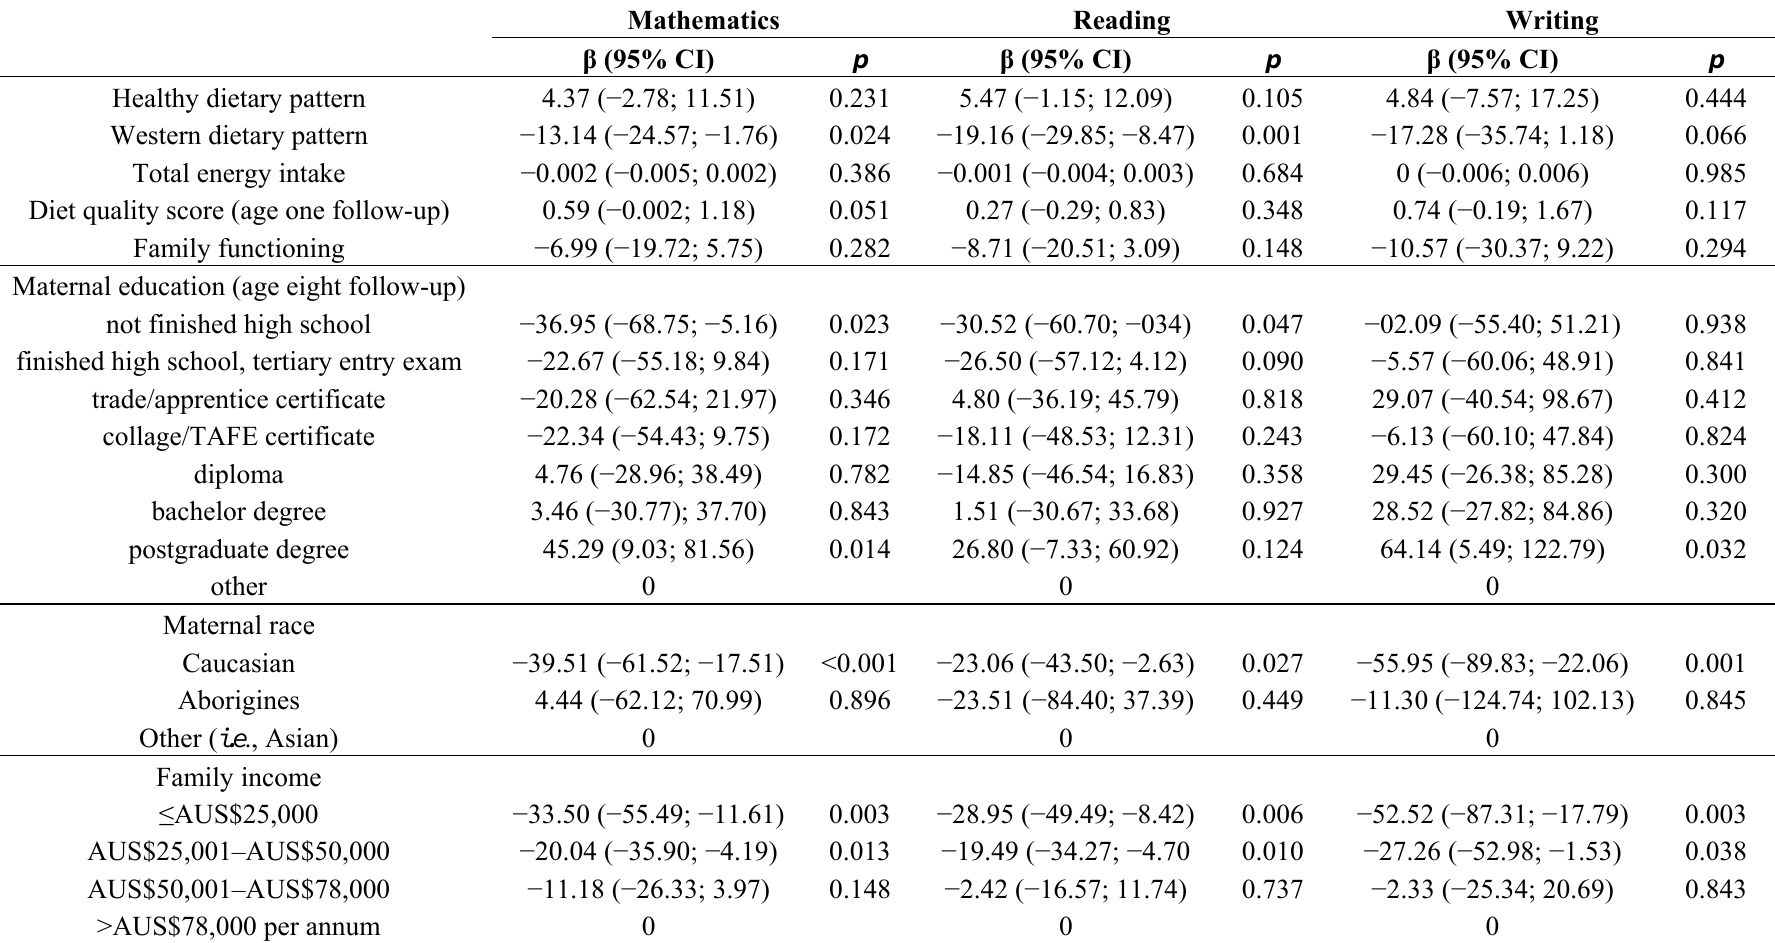
Table 3. Detailed multivariate regression analysis associations between Western and Healthy dietary patterns and mathematics, reading and writing scores and covariates at age 14 in the Western Australian Pregnancy Cohort (Raine)